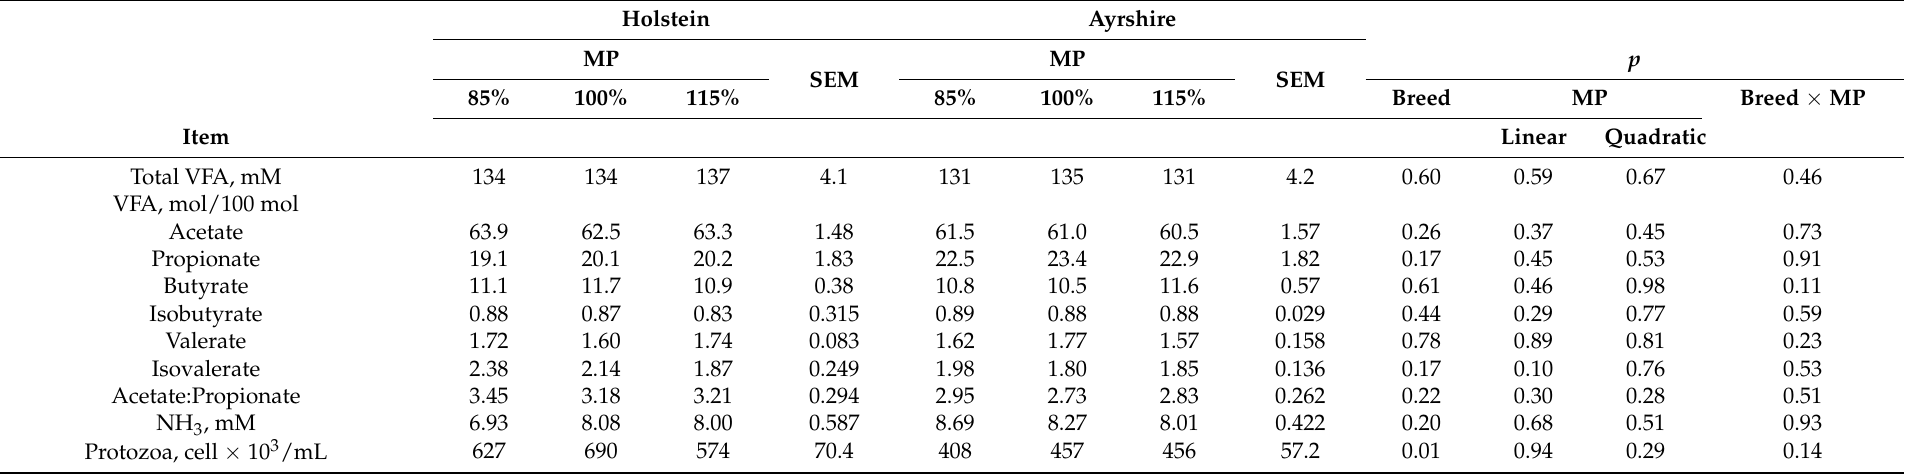
Table 4. Total VFA concentration, VFA molar proportions, NH 3 concentration, and protozoa number in ruminal fluid of lactating Holstein and Ayrshire cows fed diets formulated to provide 85%, 100%, or 115% of metabolizable protein (MP) requirement 1